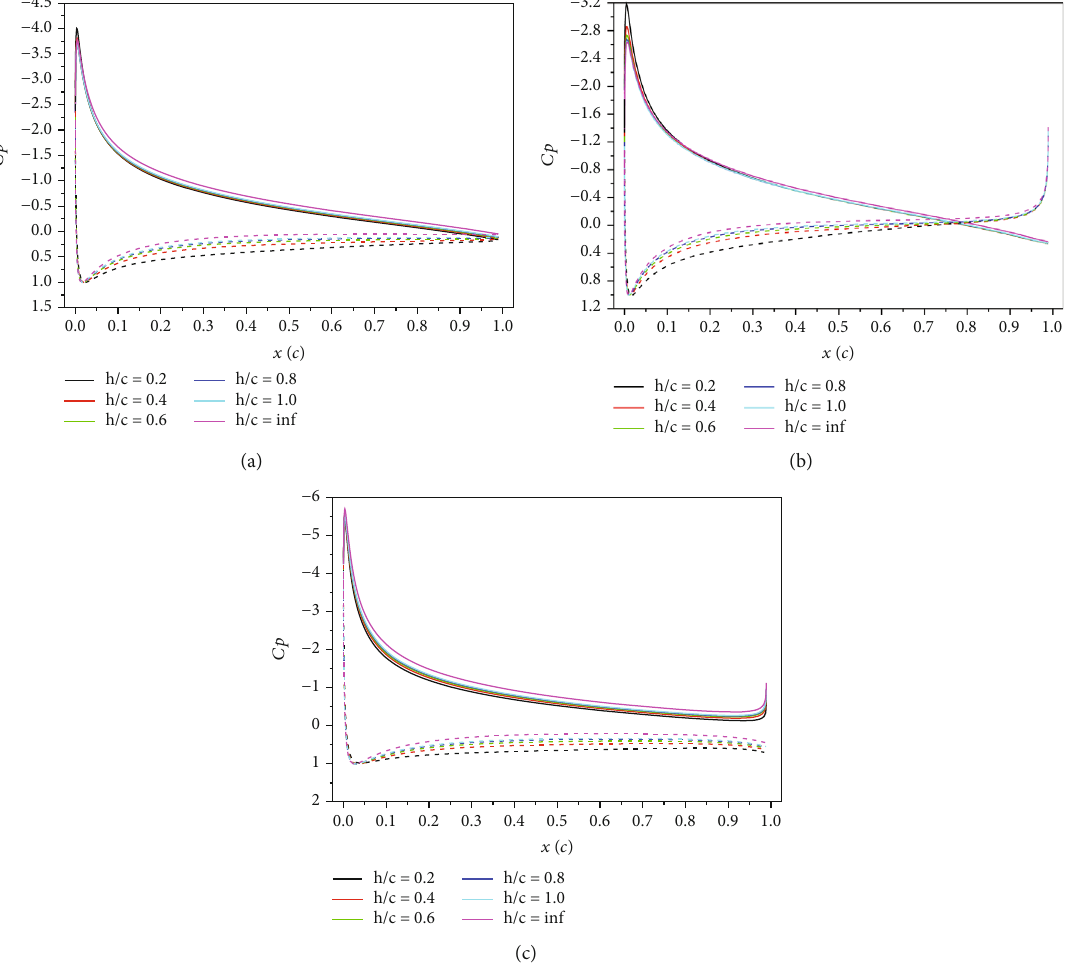
= − 0 : 013 ; (c) with C = 0 : 013 μ μ